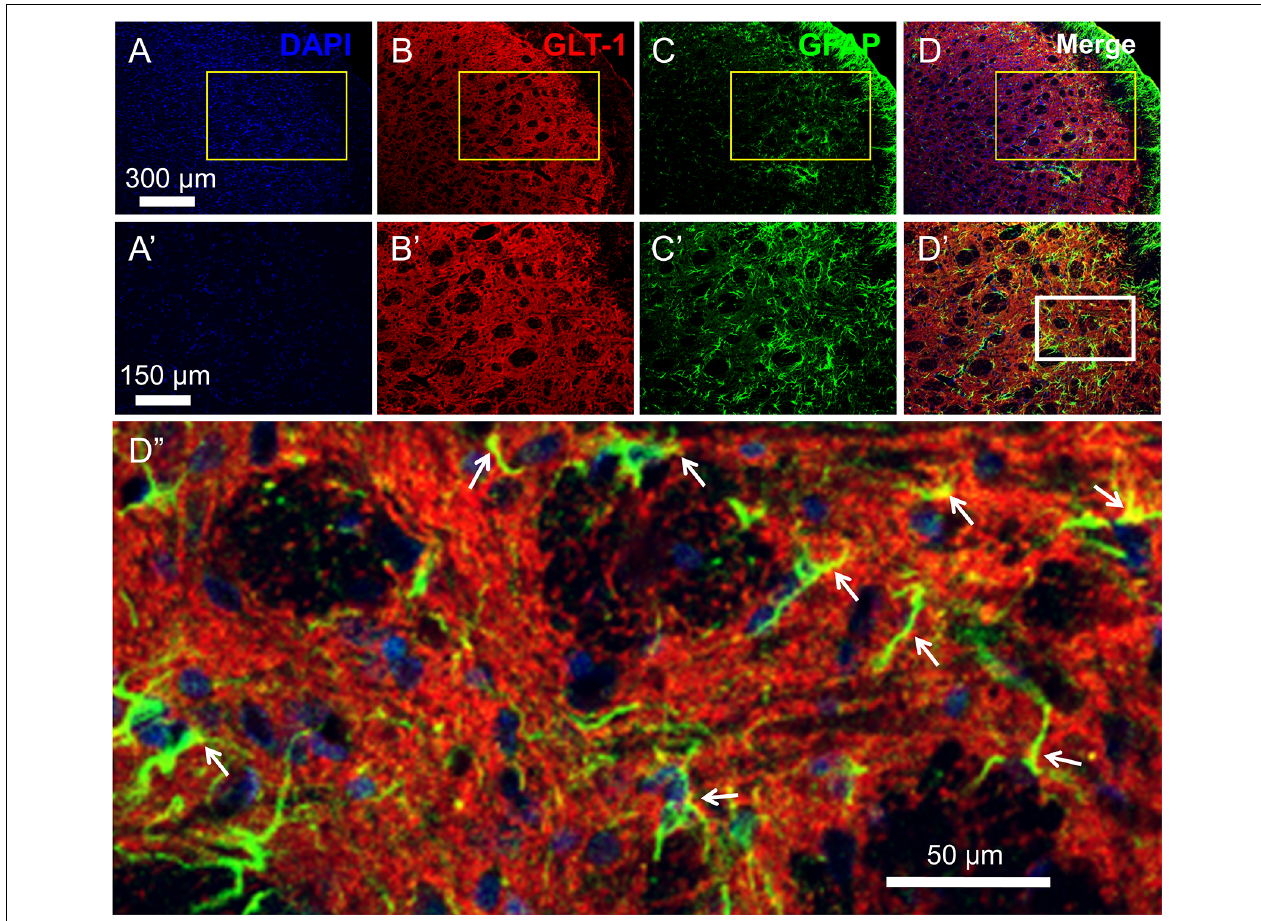
FIGURE 2 | Distribution and co-localization of glutamate transporter 1 (GLT-1) and glia fibrillary acidic protein (GFAP)-labeled profiles in the medullary dorsal horn. Panels (A–D) show triple labeling of DAPI (blue), GLT-1 (red) and GFAP (green). Panesl (A’–D’) show insets from panels (A–D) . Panel (D”) shows inset from panel (D’) . Scale = 300 µ m for (A–D) ; 150 µ m for (A’–D’) and 50 µ m for (D”) . Arrows indicate co-localization of GLT-1 and GFAP (yellow) in astrocytic